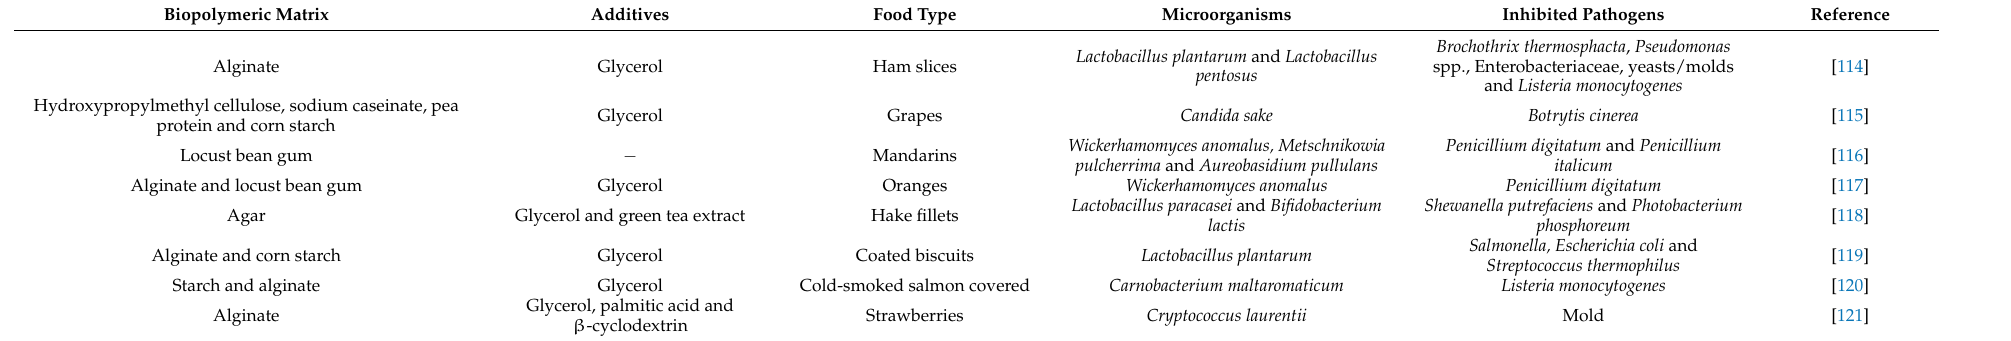
Table 4. Coatings with microorganism against pathogens applied in food